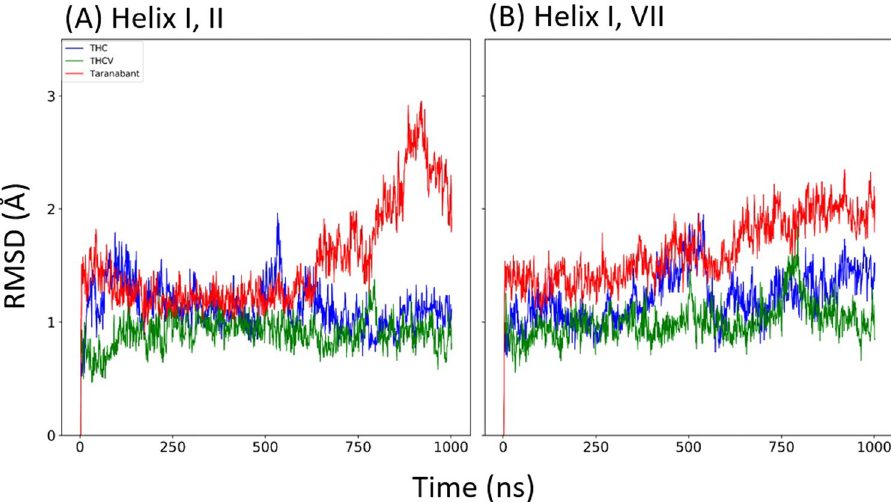
Figure 6. The RMSD values of helix pair in active state conformation. The RSMD of helix pairs ( A ) helix I, II and ( B ) helix I, VII.